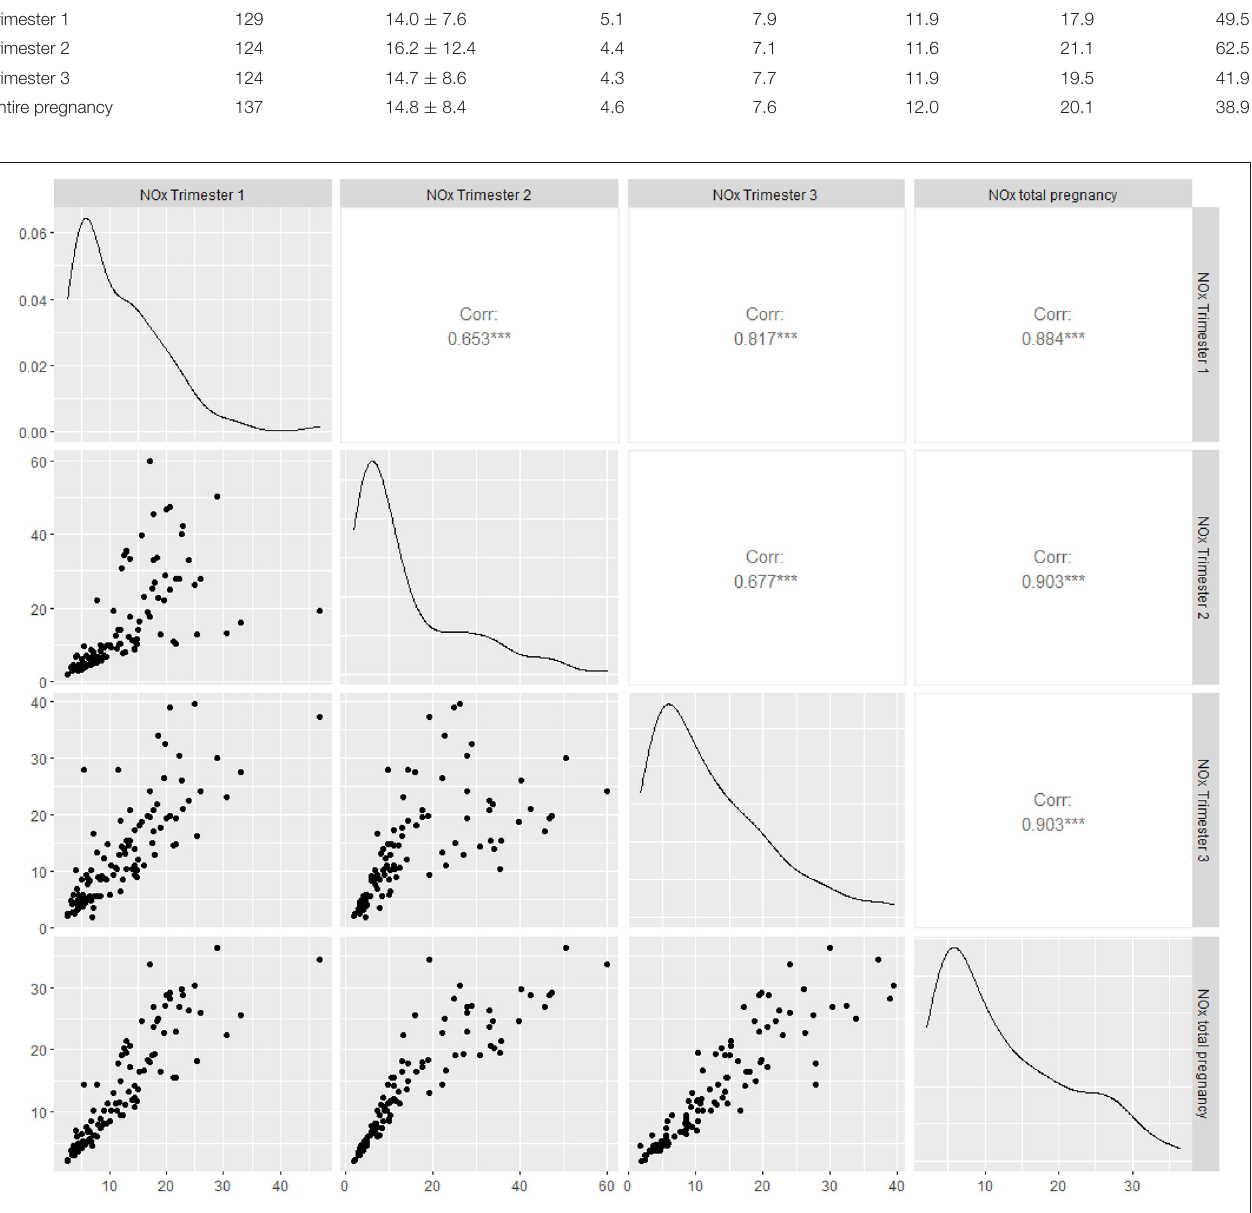
Prenatal NO Exposure and PE x Independent of maternal age, pregestational BMI, parity, season of birth and fetal sex, statistically significant associations were found between prenatal NO x exposure and PE when looking at exposure during first trimester (OR 4.0; 95% CI: 1.4, 11.1; p = ( Table 3 ). Effect estimates associated with NO x exposures during